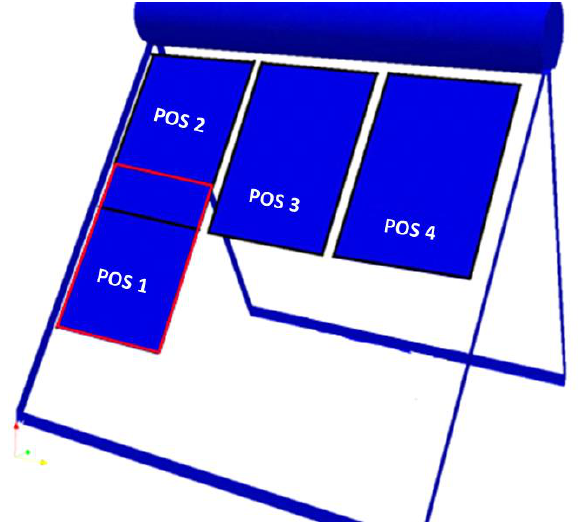
Fig. 4. Positions of MCCA on condenser surface